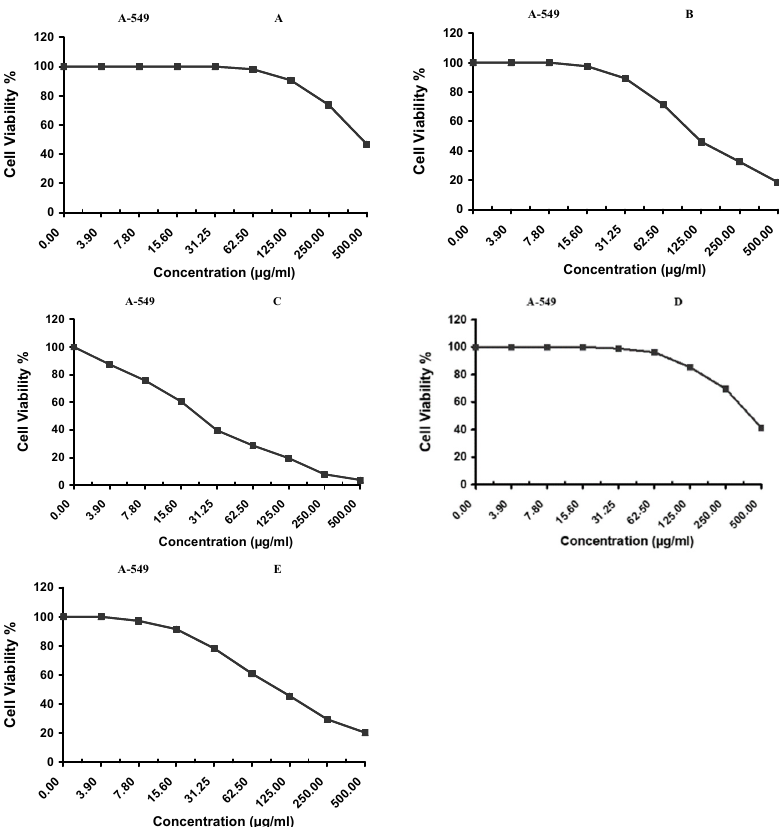
Figure A3. The percentage of cell viability of lung cancer cell lines (A-549) upon treatment with different doses of the test samples. ( A ) the unloaded PLGA NPs, ( B ) the PLGA-Cf-F 1 NPs, ( C ) the PLGA-Cf-F 2 NPs and ( D ) the PLGA-Cf-F 3 NPs. Finally, graph (E) is for the free coffee